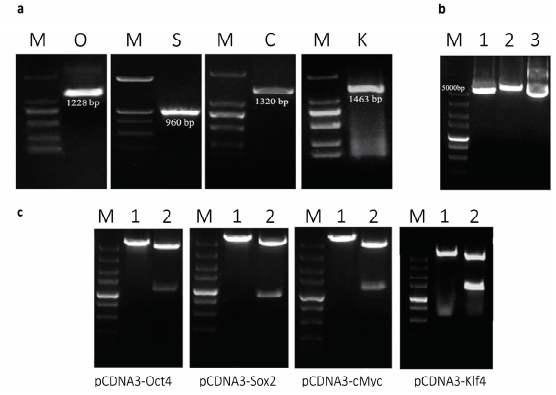
Figure 2. Plasmid construction and mRNA synthesis. ( a ) Successful